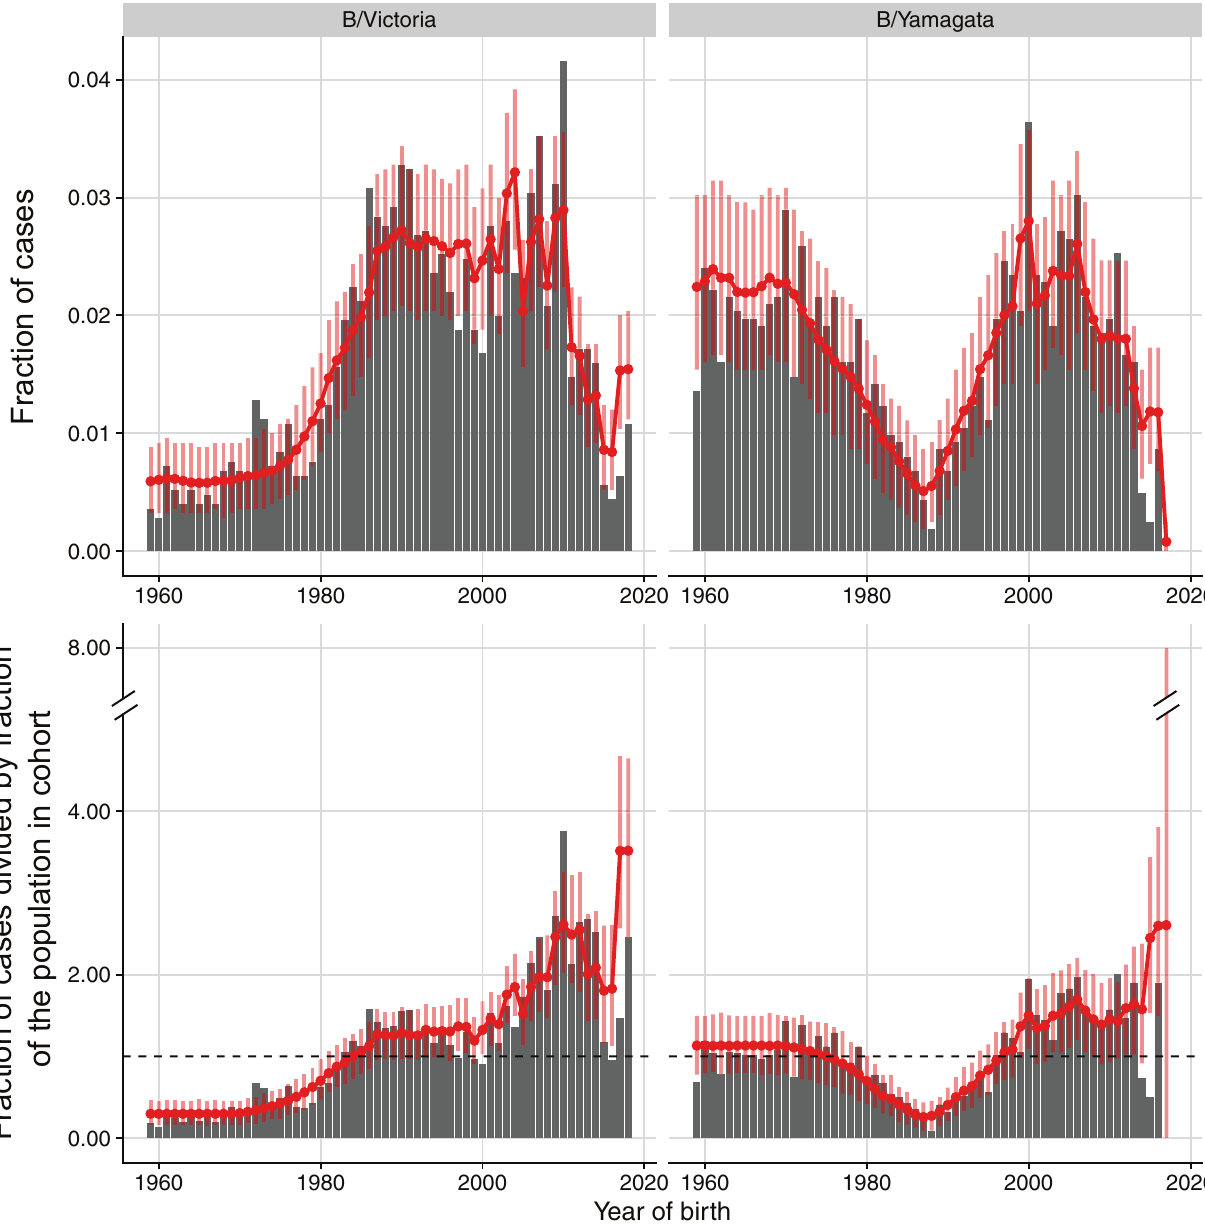
Fig. 3 Observed and predicted distributions of in fl uenza B cases in New Zealand by birth year. The model was simultaneously fi tted to the age distributions in each observation year from 2001 to 2019, accounting for uncertainty in the birth year of each reported case given the patient ’ s age. For plotting, we pooled observed and predicted numbers of cases across observation years for each birth year, assuming the earliest possible birth year for each age (e.g., an age of 10 years in 2000 was assumed to correspond to the birth year 1989). Red lines and dots show the fraction of cases in each birth cohort as predicted by the model. Vertical bars are 95% bootstrap con fi dence intervals based on n = 1000 multinomial draws from the predicted distributions indicated by the dots. In the bottom row, predicted and observed fractions of cases were normalized by dividing by the fraction of the population born in that birth year (i.e., the null expectation if all birth years were infected at the same